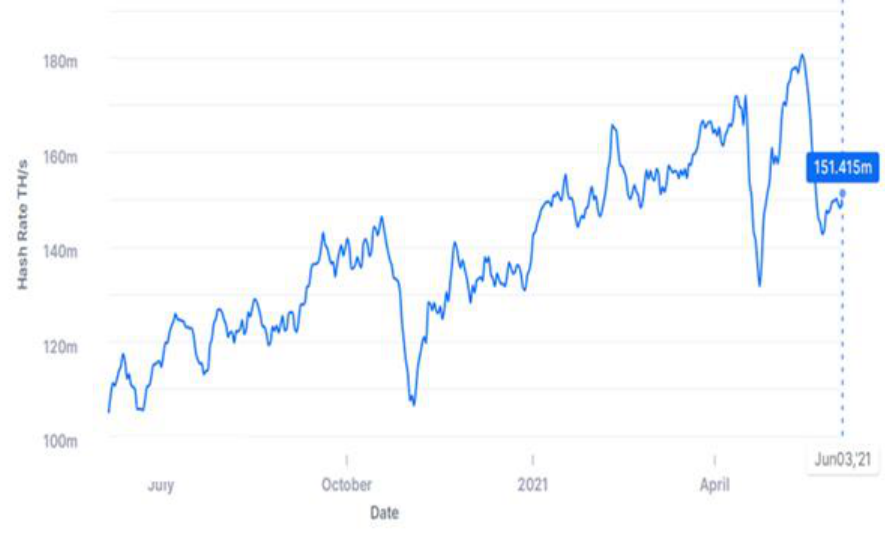
Figure 9. Total Hash rate [32].